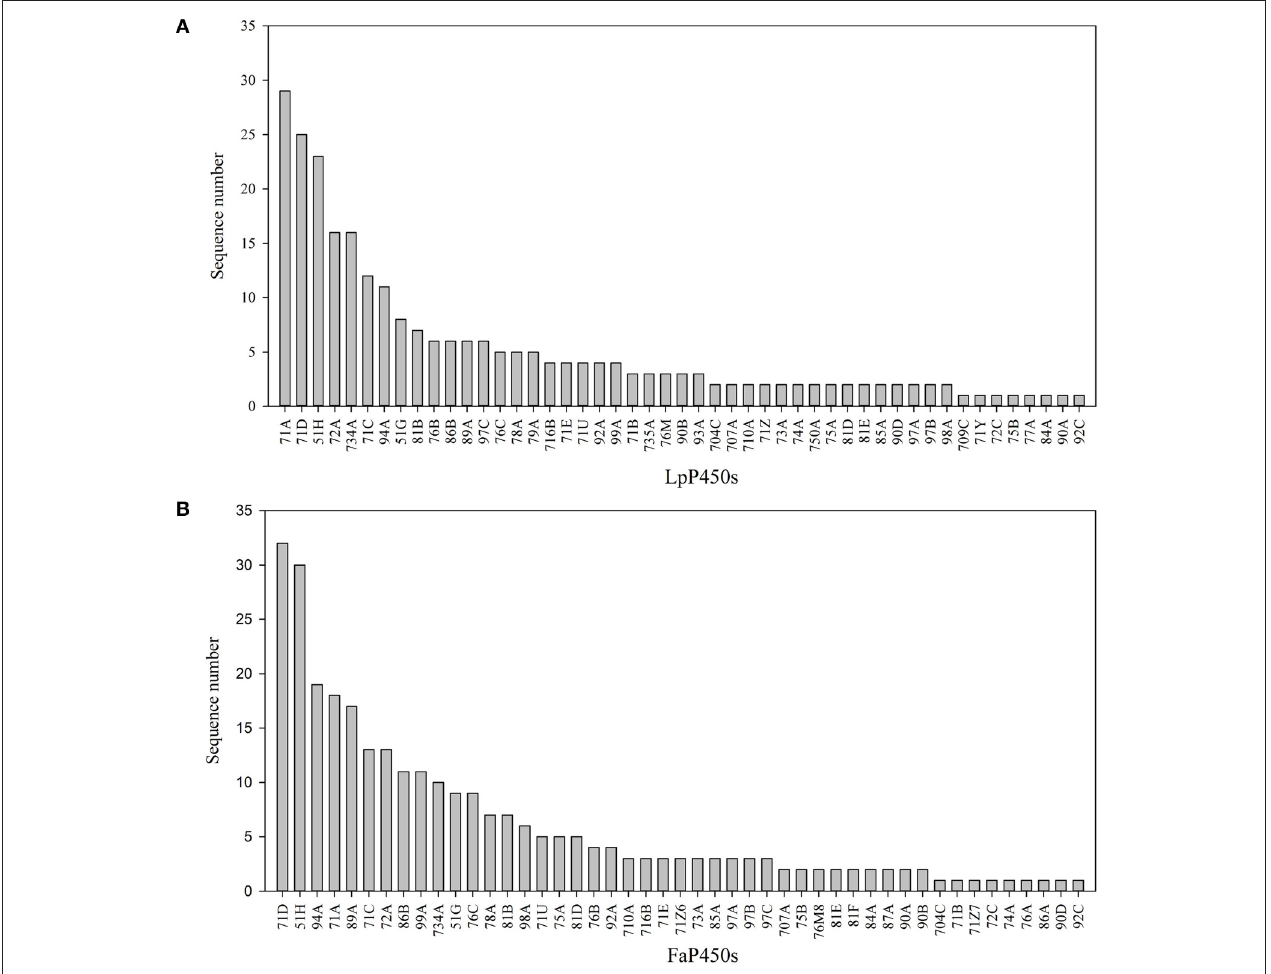
FIGURE 1 | Characteristics of the Predicted P450 Transcripts. Subfamily classification of the P450 transcripts that were identified in perennial ryegrass (A) and tall fescue (B) .